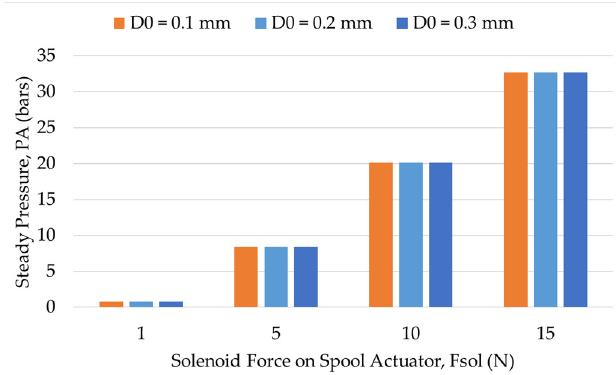
( b ) Figure 12. Transient responses for different pressure settings; ( a ) when De = 1 mm; ( b ) when De = 3 mm. 6.2.3. Influence of Damping Orifice on Output Orifices can be used as dampers in many hydraulic components [40,41]. As shown in Figures 13 and 14, we found out that the spool actuator can be damped